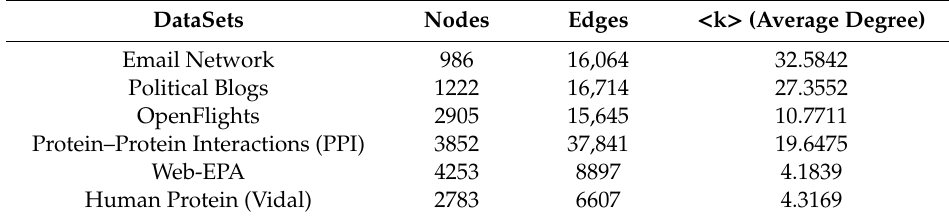
Table 3. The preprocessed network data structure